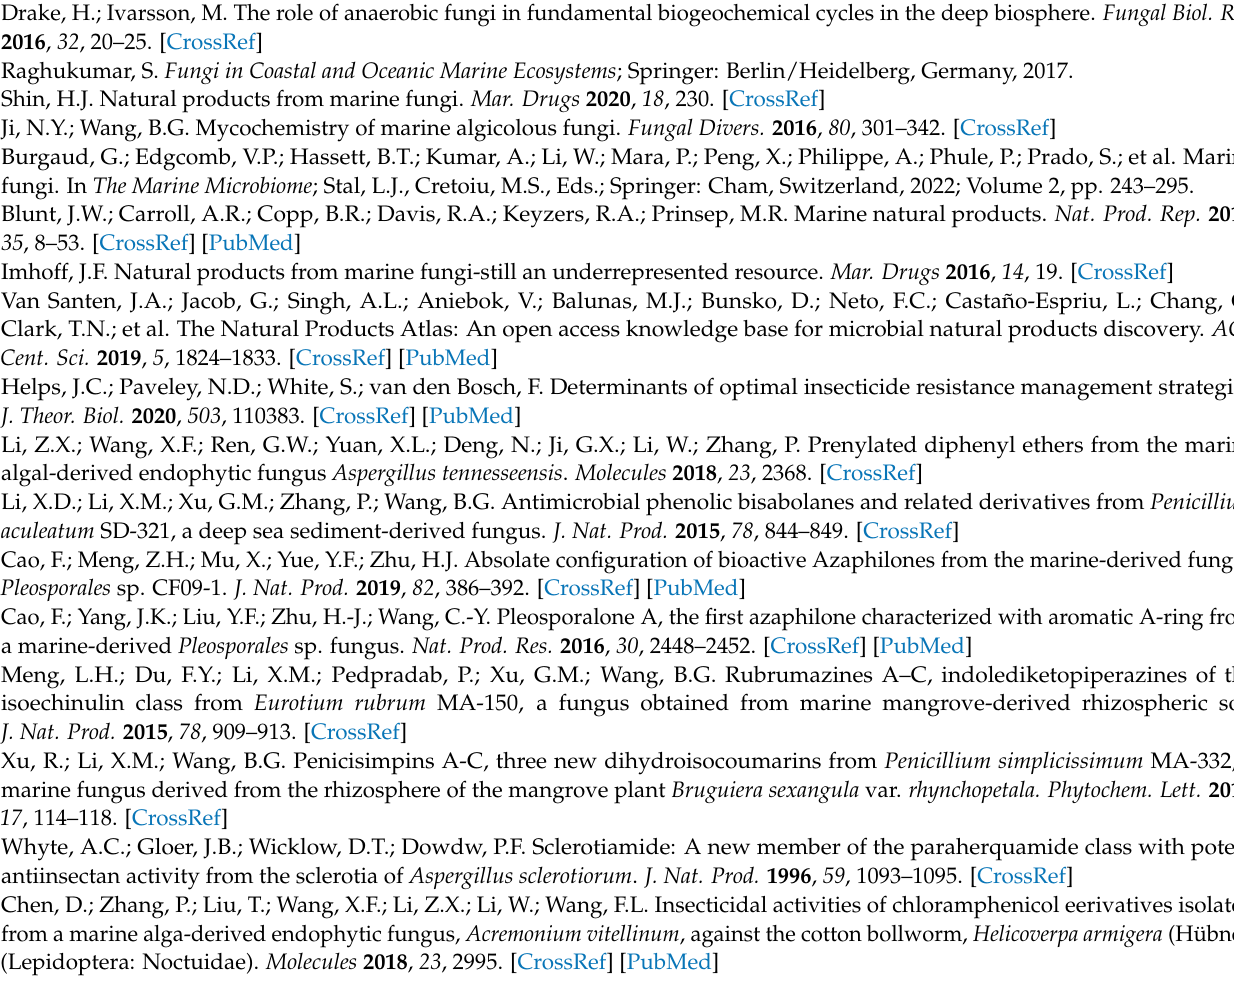
Table S1: Information for the 181 fungal